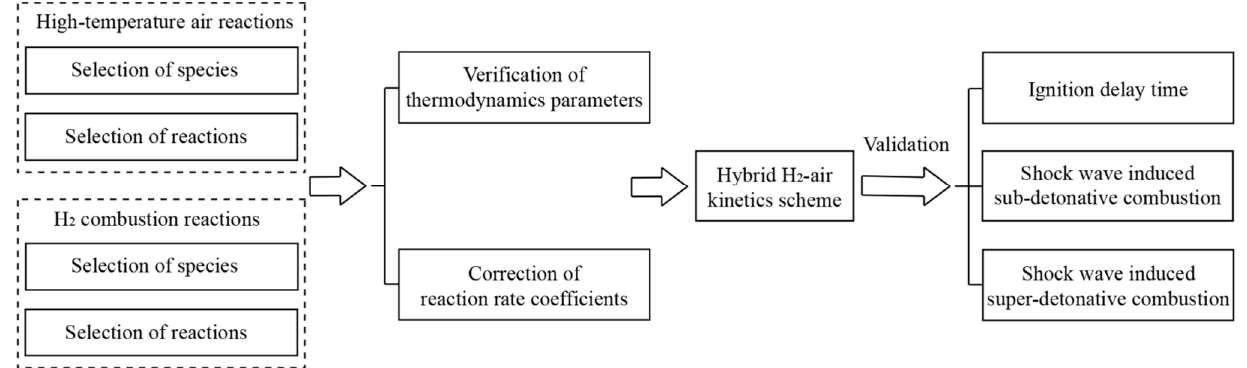
Figure 1. Process of modelling the hybrid H 2 –air kinetic scheme.